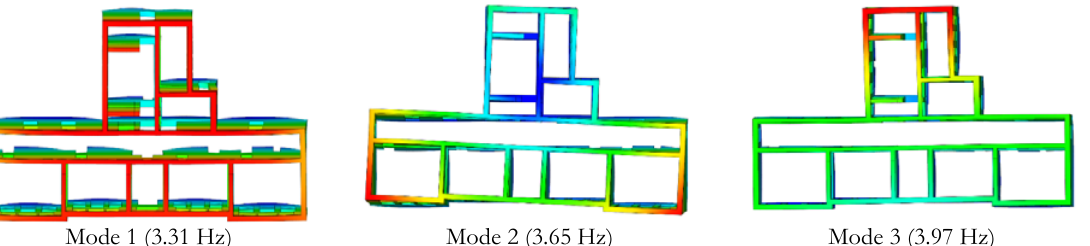
Figure 13: Mode shapes of the three global modes obtained for the calibrated model with interfaces (deformation scaling factor equal to 5 for mode